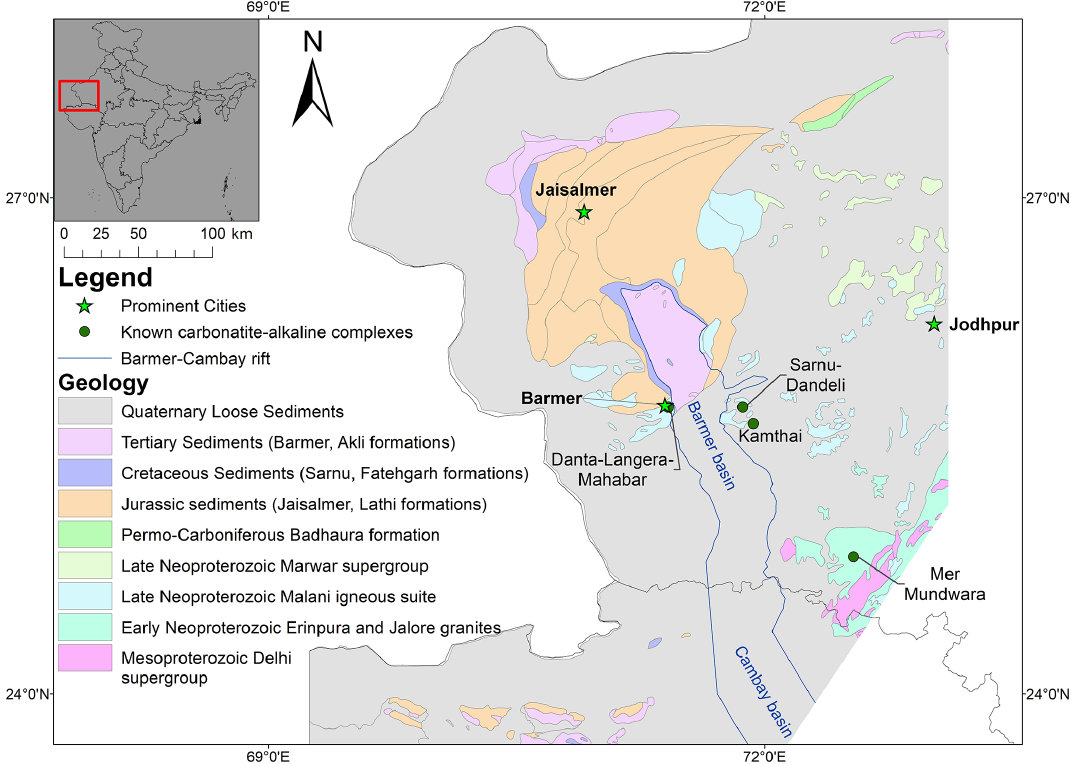
Figure 1. Geological map of the study area with known carbonatite–alkaline